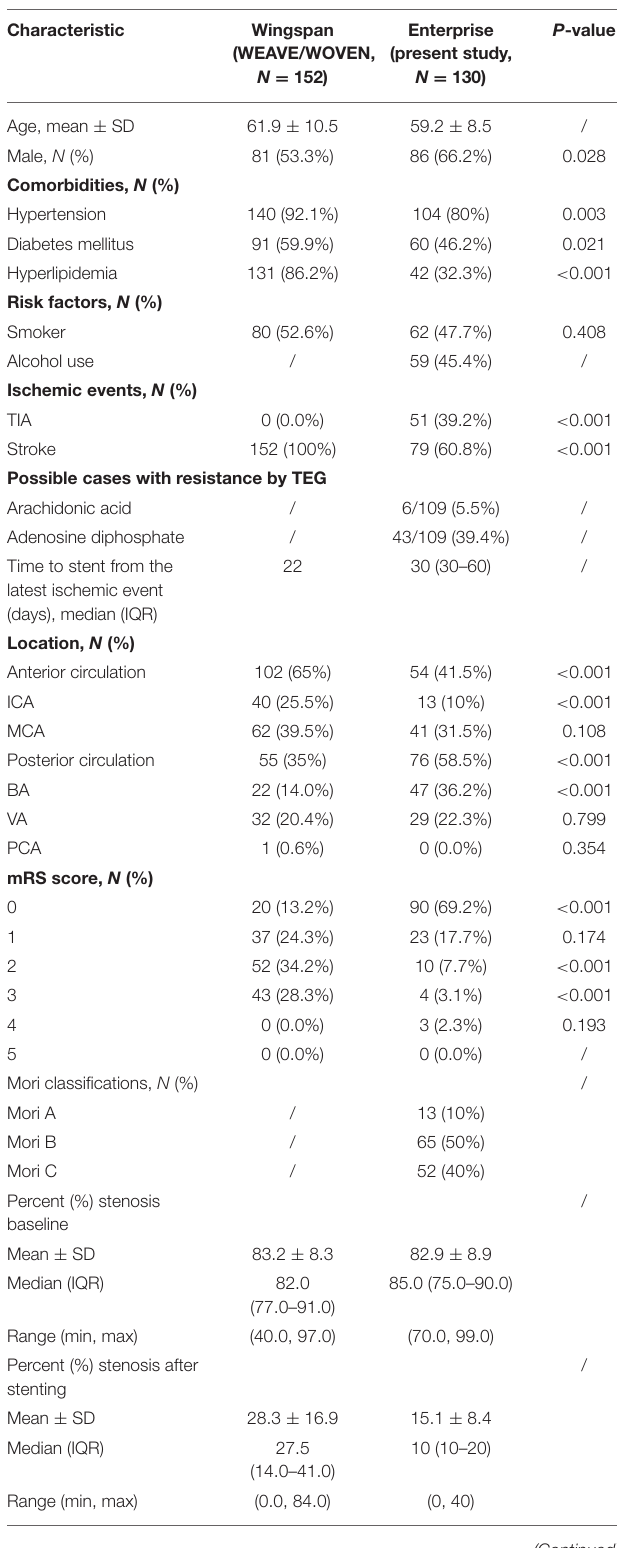
TABLE 1 | Comparison of baseline data between the WEAVE/WOVEN trial and the present study.